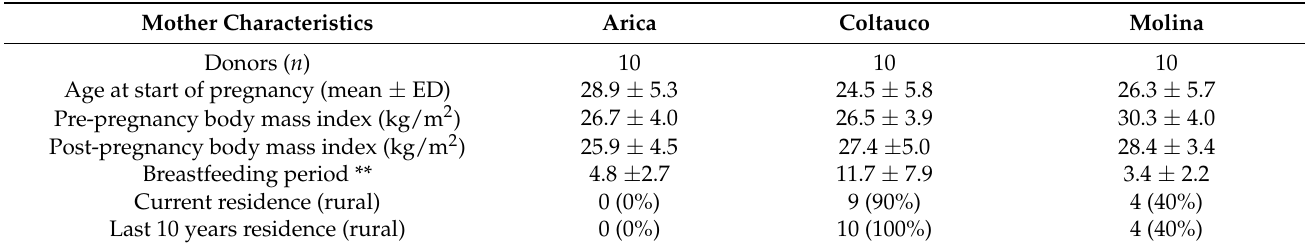
Table 1. Demographic information for pooled samples of women from 3 regions of Chile.